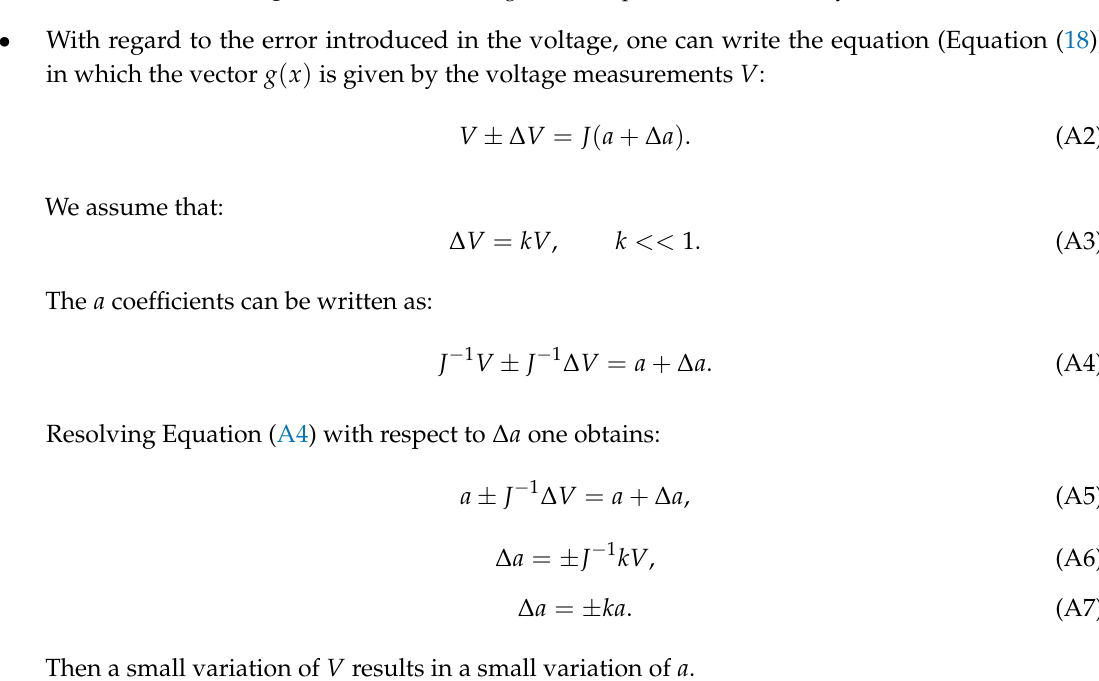
Figure A1. ∆ J at according to the temperature of